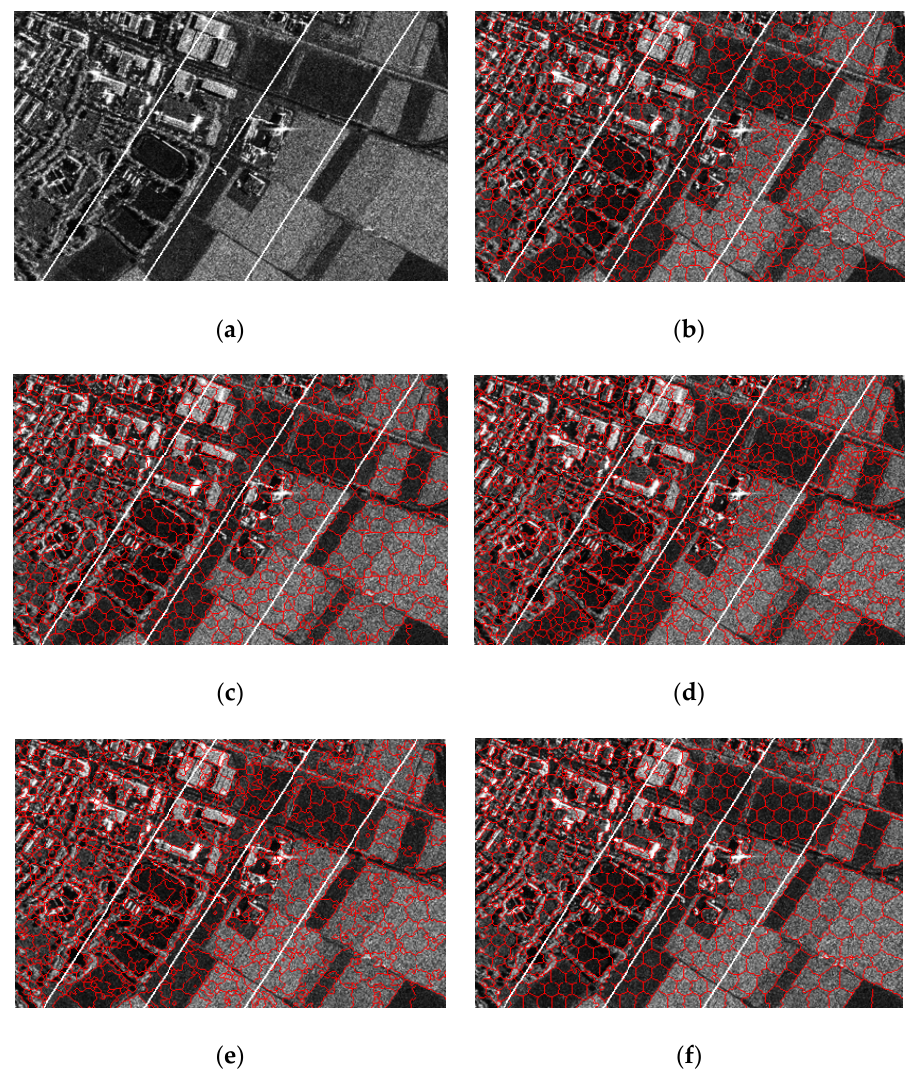
Figure 20. Resulting superpixels of Noerdlinger with m set to six and K set to 900, 700, 500, and 300 for regions A, B, C, and D. ( a ) Original SAR image; ( b ) SLIC; ( c ) PILS; ( d ) LBSLIC; ( e ) PBSLIC; and ( f ) PSDSD.